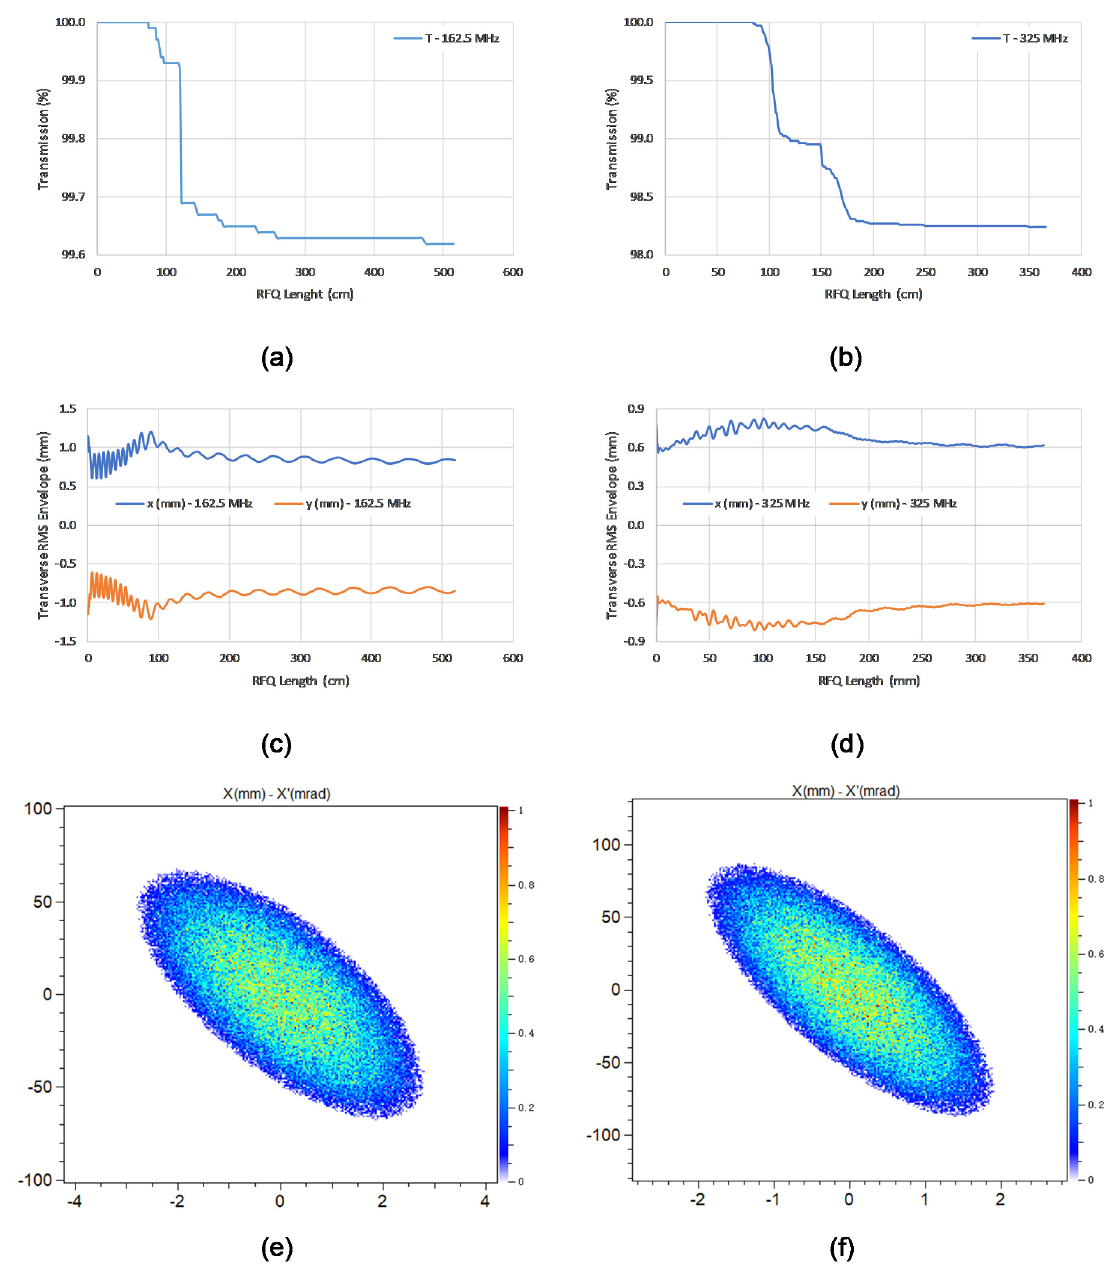
Figure 5. Simulated beam transmission efficiencies, transverse RMS envelopes and input transverse particle distributions (x-x’) of beam dynamics in the 162.5 MHz ( a , c , e ) and 325 MHz ( b , d , f ) RFQs.